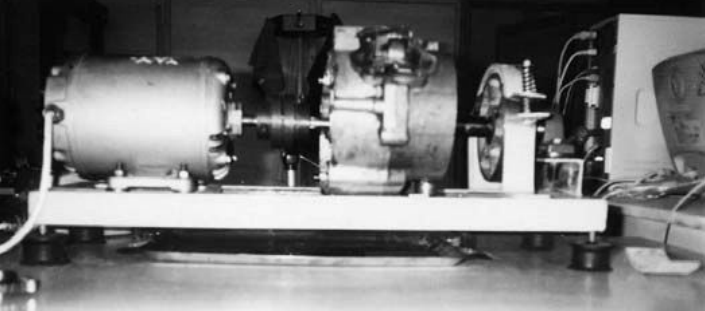
Fig. 2. Test rig overview [3].